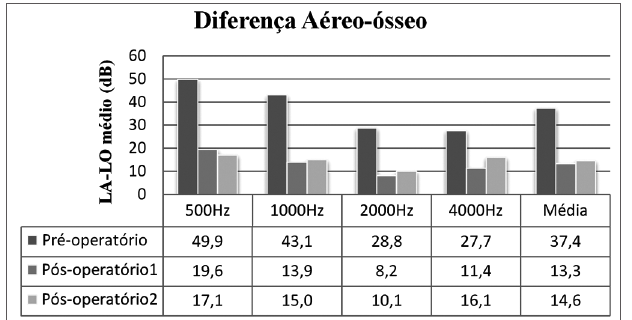
Figura 3. Diferença aéreo-óssea para as frequências e valor médio da sua média. LA: Limiar Aéreo; LO: Limiar Ósseo. Em relação aos limiares ósseos (LO), houve declínio